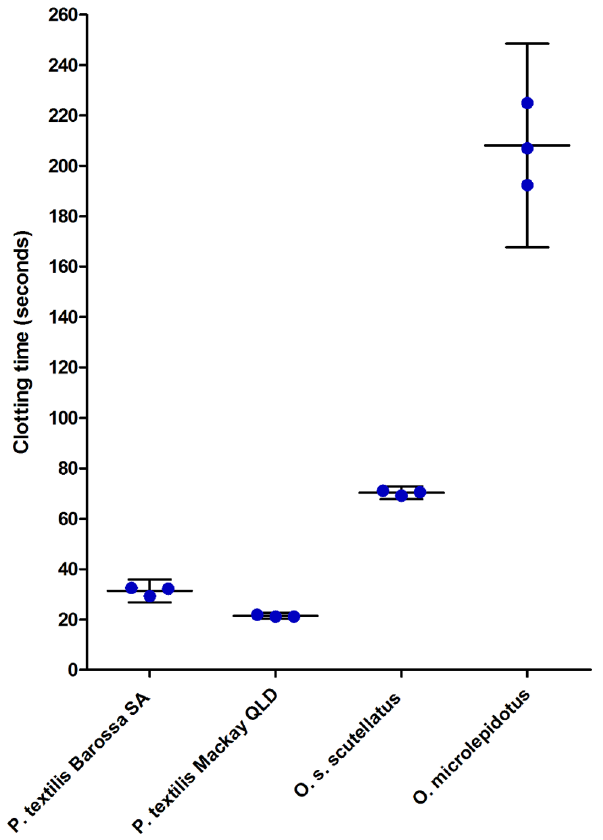
Figure 3. Venom procoagulant activity in rat plasma. 0.5 m g venom (in 50 m l saline) per 100 m l citrated plasma recalcified with 4 m mol CaCl 2 (means and 95% CI shown).